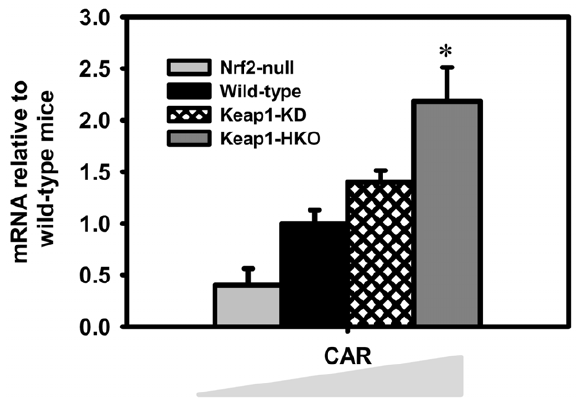
Figure 7. Messenger RNA of CAR in ‘‘gene dose-response’’ model. Data of Nrf2-null, Keap1-KD, and Keap1-HKO mice are normalized by the value of wild-type mice and presented as Mean 6 S.E.M. of five mice per group. Asterisks (*) indicate statistically significant differences from wild-type mice (p ,